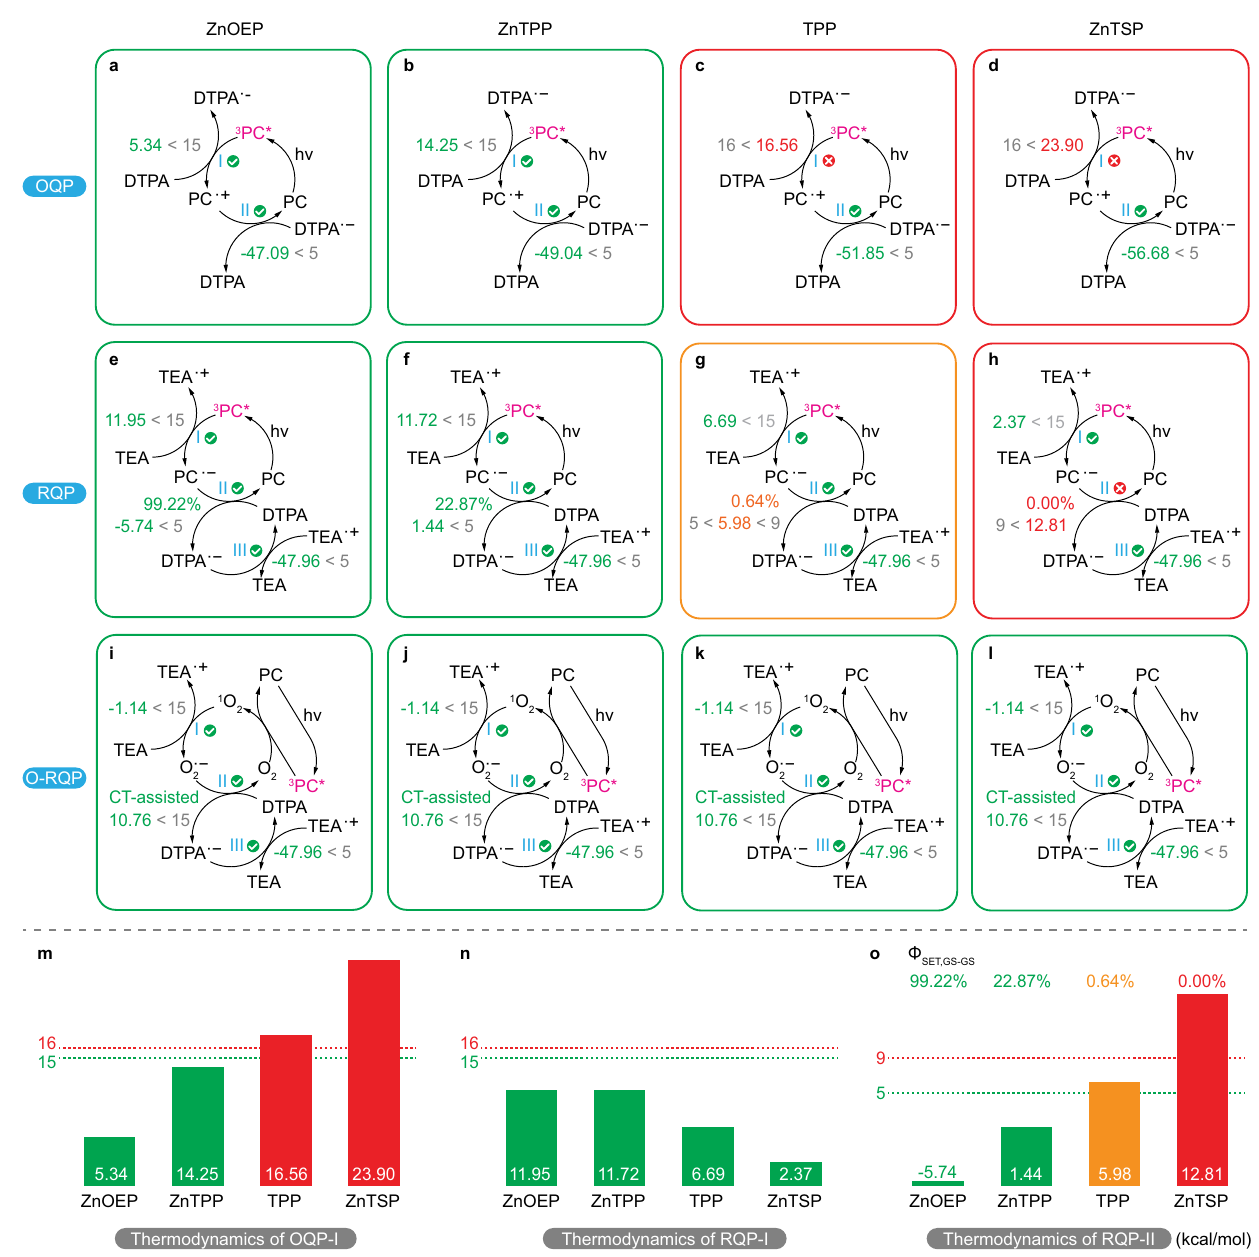
Fig. 4 Schematic representation of thermodynamic viability of mechanistic steps. a – l Mechanistic diagrams with Δ G of key steps denoted in comparison to corresponding thresholds for PET-RAFT polymerisation via OQP ( a – d ), RQP ( e – h ) and O-RQP ( i – l ), catalysed by ZnOEP ( a , e , i ), ZnTPP ( b , f , j ), TPP ( c , g , k ) and ZnTSP ( d , h , l ), respectively. Green is favourable, orange is less ef fi cient and red indicates inertness. Coloured values are the Δ G of the corresponding process in kcal/mol, in conjunction with the threshold in grey (derived in the “ Methods ” section). Coloured percentage values are Φ SET,GS-GS of the corresponding process. Bottom: Bar charts illustrating Δ G of the critical catalytic steps regarding the activation of OQP (OQP-I, m ) and RQP (RQP-I, n and RQP-II, o ) for ZnOEP, ZnTPP, TPP and ZnTSP on a comparative basis, with thermodynamic thresholds in kcal/mol (green dotted line: activation threshold; red dotted line: activation limit). Φ ET,GS – GS : quantum yield of the single electron transfer process between two ground states, de fi ned by Supplementary Eq. 1. OQP oxidative quenching pathway, RQP reductive quenching pathway, O-RQP oxygen-mediated reductive quenching pathway. ES – GS SET single electron transfer from an excited state to a ground state, GS – GS SET single electron transfer between two ground states, CT-assisted SET single electron transfer assisted by charge transfer in the donor – acceptor